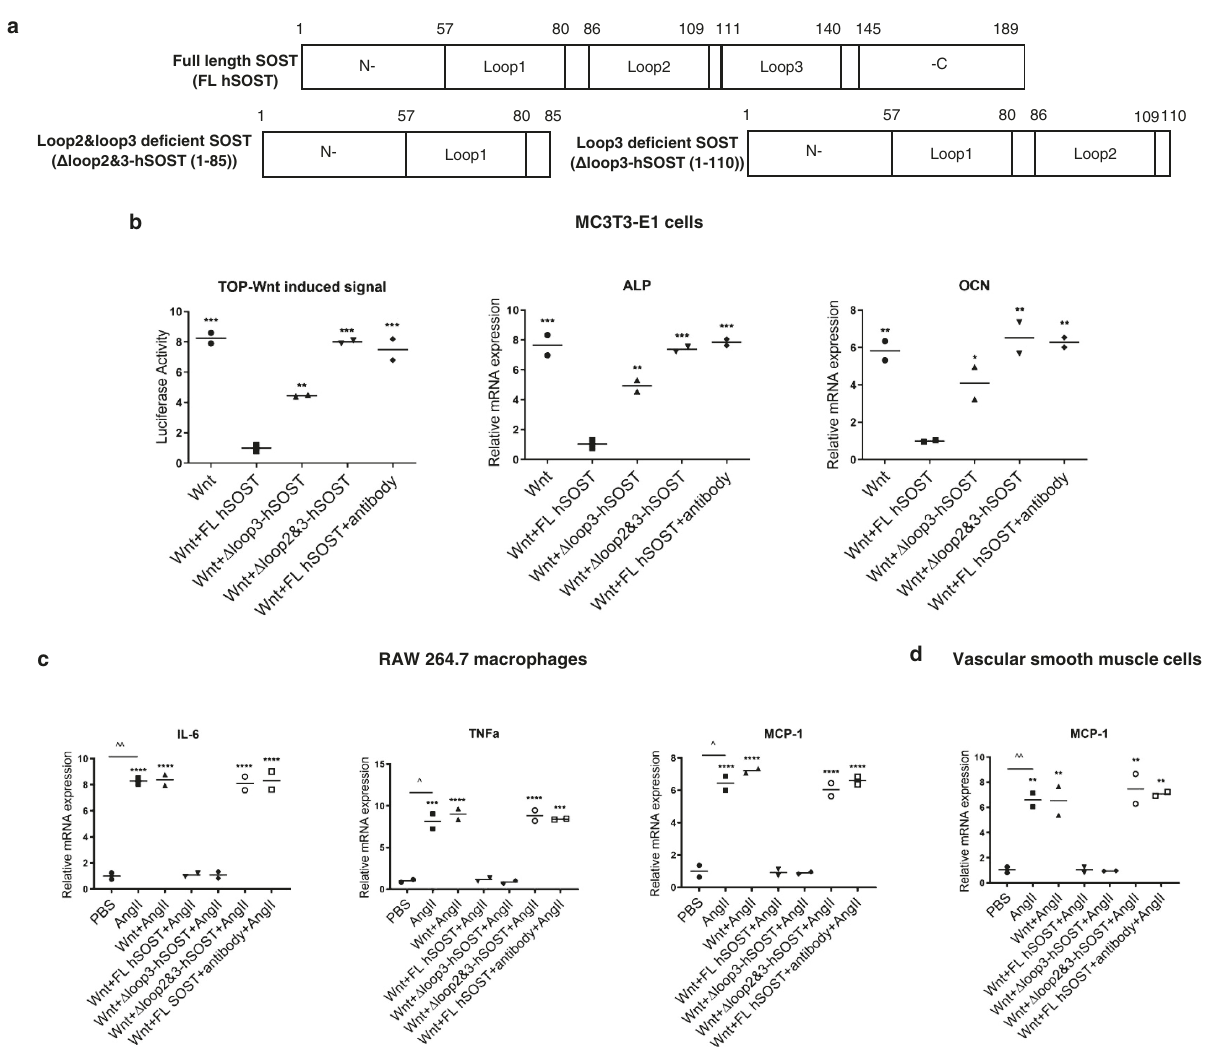
Fig. 1 Effects of sclerostin loops on regulating Wnt signalling and osteogenic potential in MC3T3-E1 cells, and on regulating in fl ammatory cytokines/ chemokines in macrophages and vascular smooth muscle cells (VSMCs). a Schematic diagram of the primary structures of full-length sclerostin and sclerostin truncations. Full-length human sclerostin (FL hSOST), sclerostin with loop2&3 de fi ciency by genetic truncation ( Δ loop2&3-hSOST(1-85)) and sclerostin with loop3 de fi ciency by genetic truncation ( Δ loop3-hSOST(1-110)). b The effect of sclerostin on regulating Wnt signalling and osteogenic potential in MC3T3-E1 cells. * p < 0.05; ** p < 0.01 and *** p < 0.005 for a comparison vs . Wnt + FL hSOST group by one-way ANOVA with Tukey ’ s post-hoc test. TOP-Wnt induced signal: p = 0.0001 (Wnt), p = 0.0034 (Wnt + Δ loo p 3-hSOST), p = 0.0001 (Wnt + Δ loop2&3-hSOST), p = 0.0002 (Wnt + FL hSOST + antibody); ALP: p = 0.0002 (Wnt), p = 0.0026 (Wnt + Δ loo p 3-hSOST), p = 0.0003 (Wnt + Δ loop2&3-hSOST), p = 0.0002 (Wnt + FL hSOST + antibody); OCN: p = 0.0066 (Wnt), p = 0.0404 (Wnt + Δ loo p 3-hSOST), p = 0.0037 (Wnt + Δ loop2&3-hSOST), p = 0.0045 (Wnt + FL hSOST + antibody). c The effect of sclerostin on regulating the mRNA levels of cytokines/chemokines in RAW264.7 macrophages. ^ p < 0.05 and ^^ p < 0.01 for a comparison between the PBS and AngII groups by a two-tailed unpaired t test. p = 0.0022 (IL-6), p = 0.0164 (TNF- α ), p = 0.0103 (MCP-1).